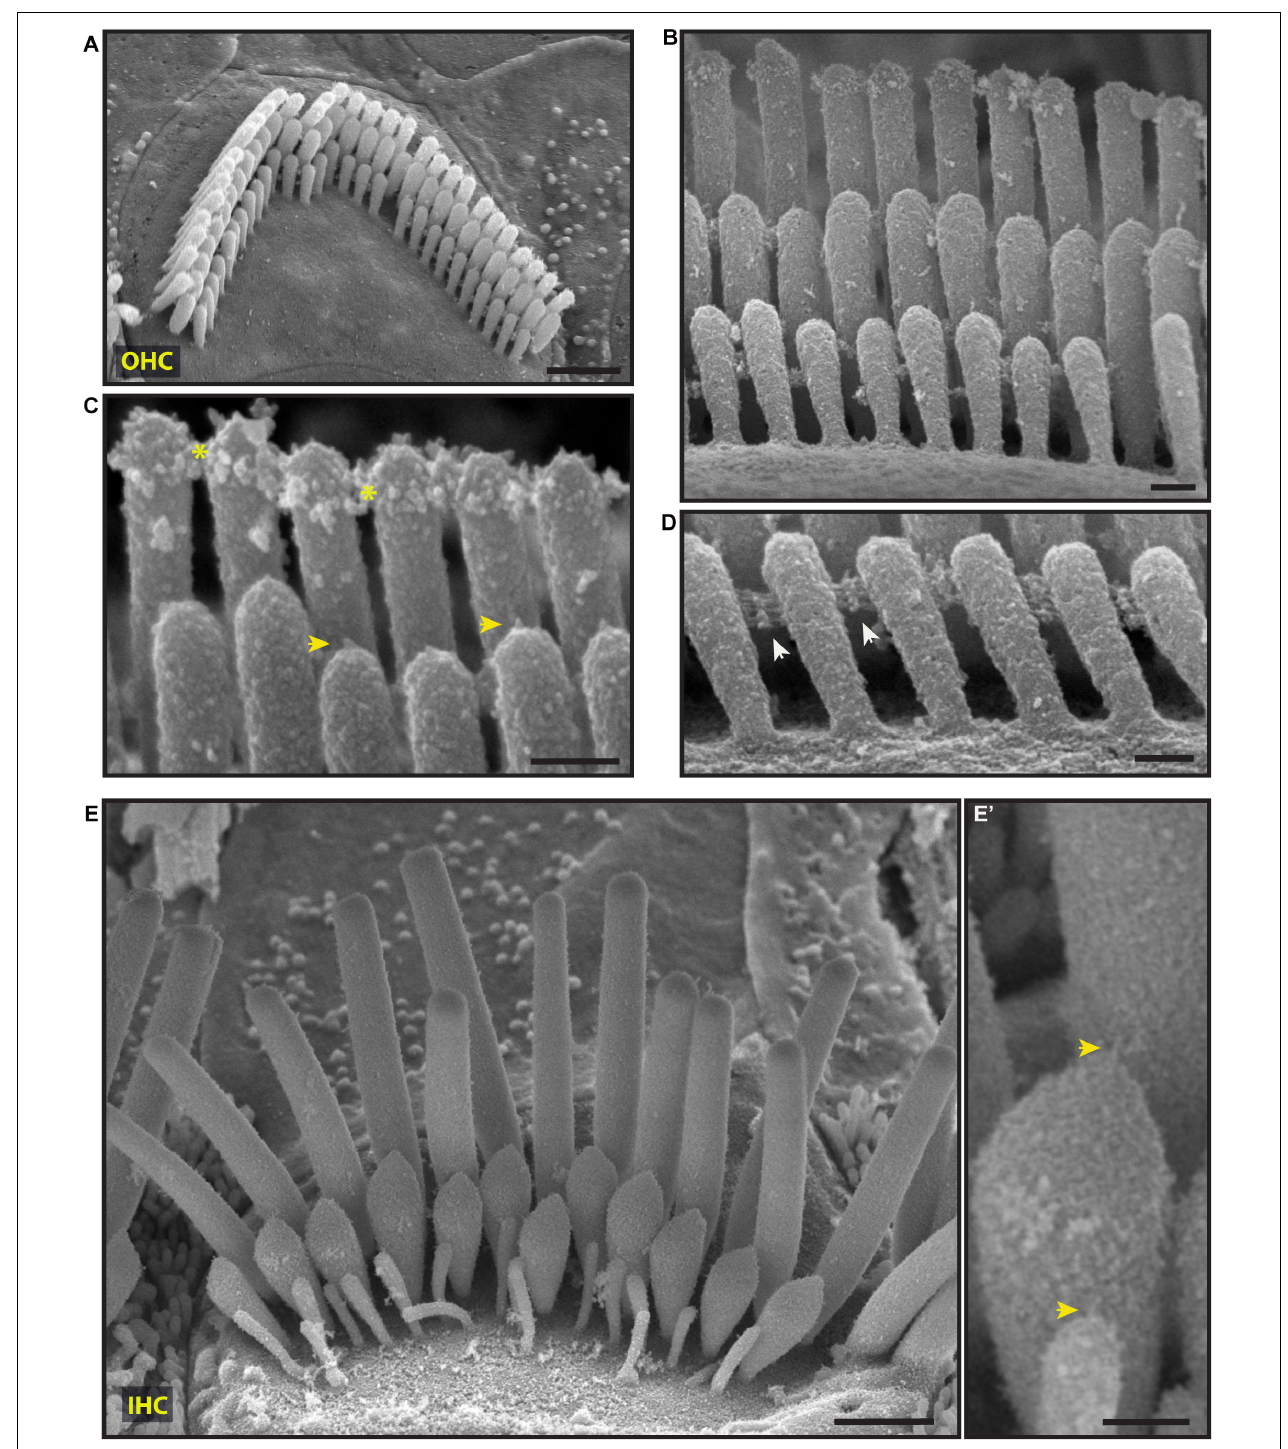
FIGURE 4 | Representative scanning electron micrographs of hair bundles of the adult, wild-type mouse cochlea. (A–D) Mature OHC bundles from the middle region of the cochlea. OHC bundles contain tip links (yellow arrows in C ), tectorial membrane attachment crowns (yellow asterisks in C ), and horizontal top connectors (white arrows in D ). The stereocilia surface appears to be relatively smooth suggesting the absence of the cell-coat material. (E,E’) Mature IHC bundle from the middle region of the cochlea. Tip links (yellow arrows in E’ ) connect the tips of adjacent stereocilia. The surface of the stereocilia is relatively smooth in appearance which indicates the absence of stereocilia coat. Samples were processed with the modified OTOTO protocol, sputter-coated with 5 nm platinum, and imaged using SE mode. Scale bars: (A,E) 1 µ m; (B–D,E’) 100 nm.